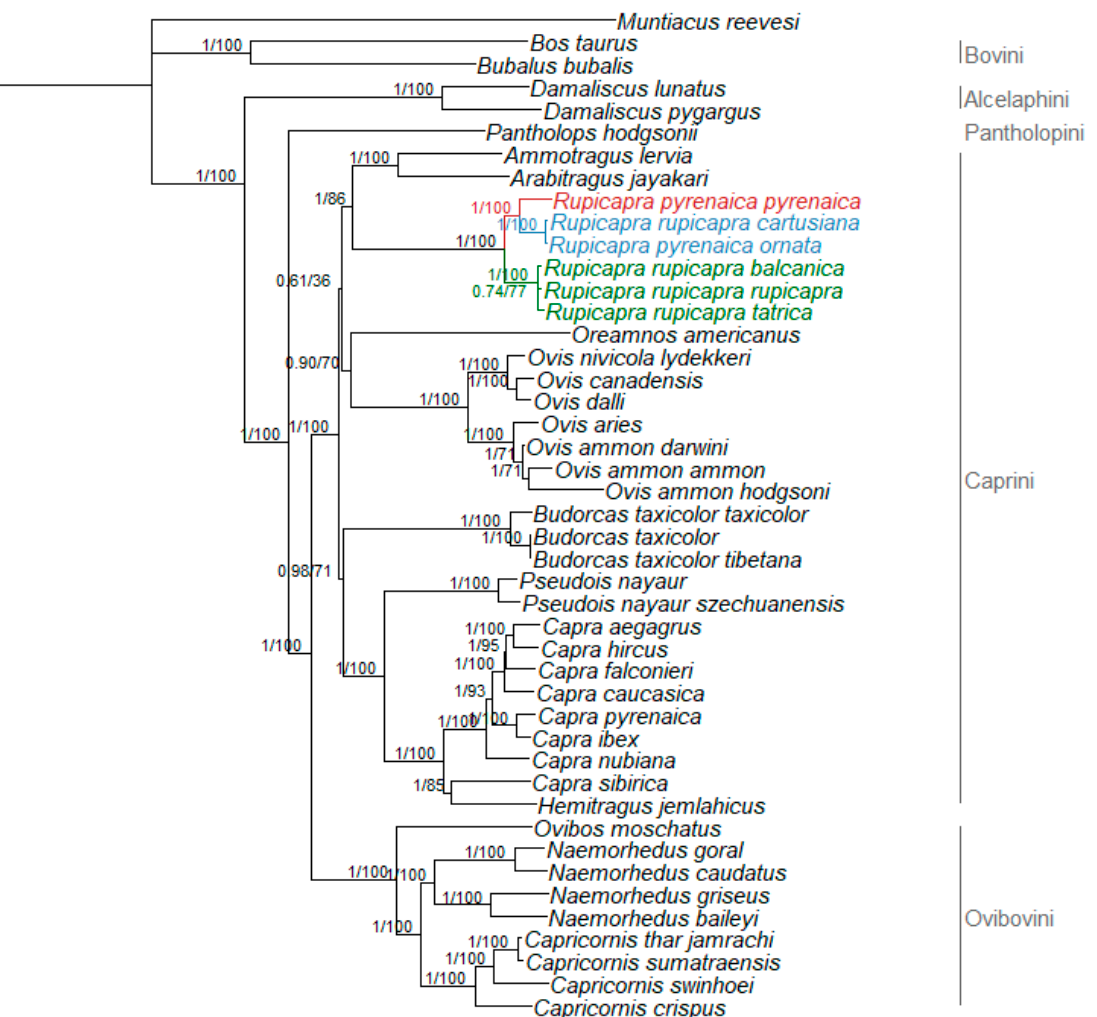
Figure 2. Rooted phylogenetic tree obtained by Bayesian inference for the whole Caprinae . Nodal supports are indicated above the nodes (posterior probability for Bayesian inference and bootstrap for maximum likelihood, respectively). Colored branches represent Rupicapra clades: red—clade W; blue—clade C; and green—clade E.